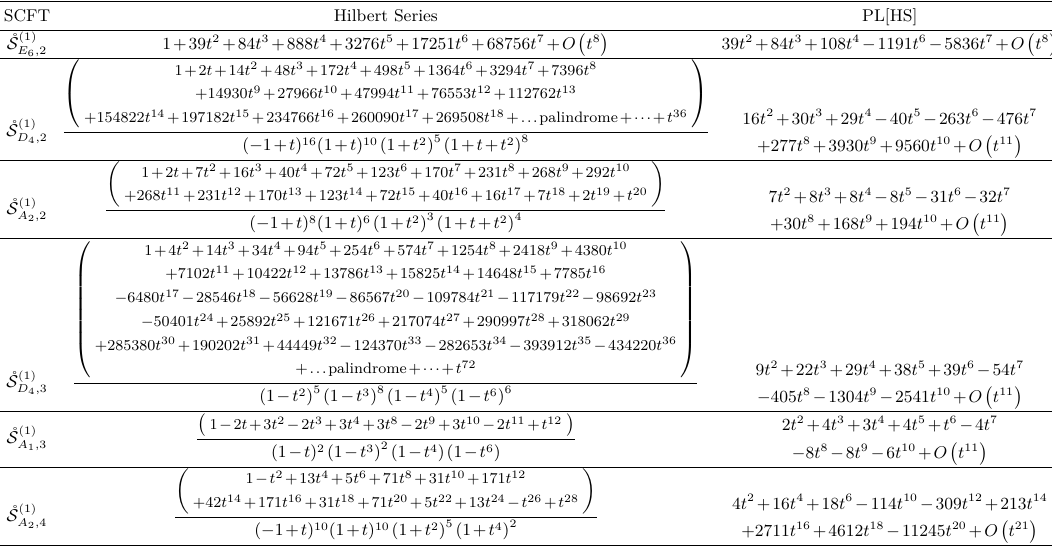
Table 11. Coulomb branch Hilbert series and plethystic logarithm for the magnetic quivers of ˚ S ( r =1) G,‘